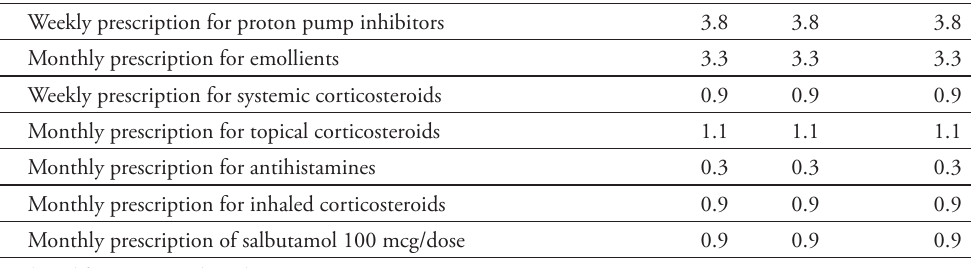
Table 2. Units of Resources Required To Manage CMPA and its Allergic Manifestations* Mean Number of Prescriptions per Patient Weekly prescription for proton pump inhibitors